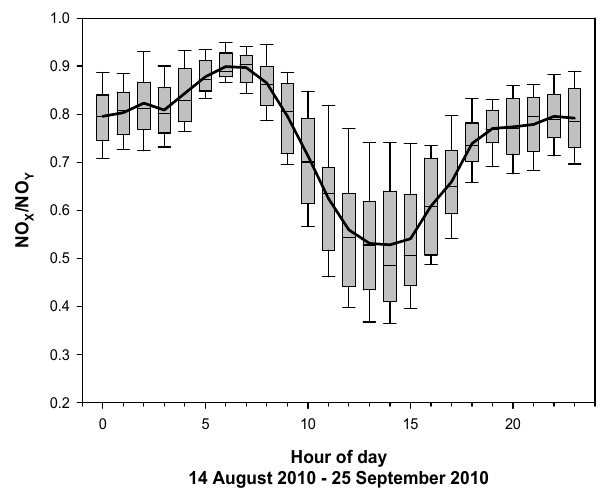
Fig. 4. Diurnal profiles of the ratio of NO X to NO Y during the summer of 2010 (5 Aug – 25 Sep).